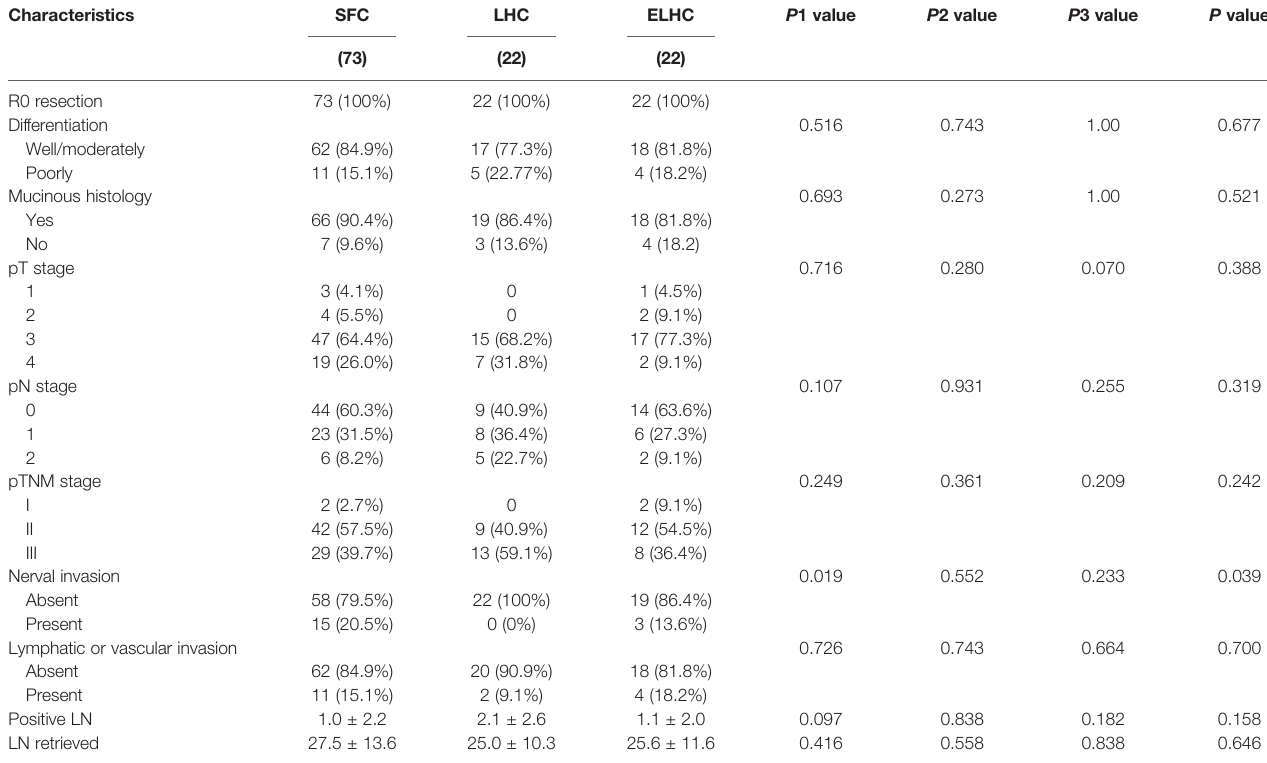
TABLE 3 | Pathological data. Characteristics